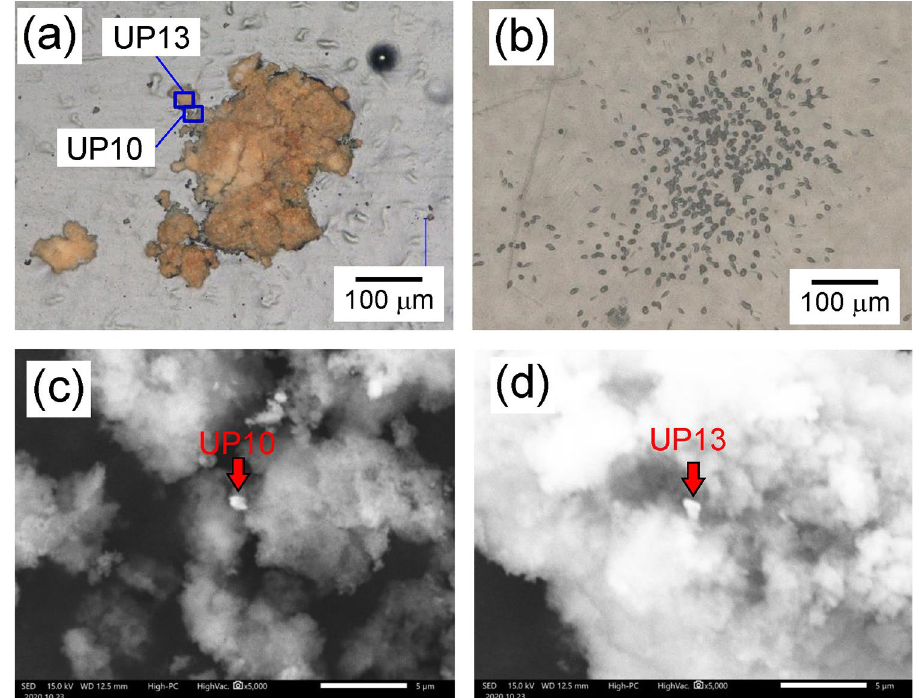
Figure 4. Example of an α-emitter particle. ( a ) Optical image of typical α-emitter particles, i.e., Fe particles with U particles. ( b ) Alpha tracks of the particles in ( a ). ( c ) Magnified SEM images for UP10 and ( d ) UP13 as indicated by the blue square in panel ( a